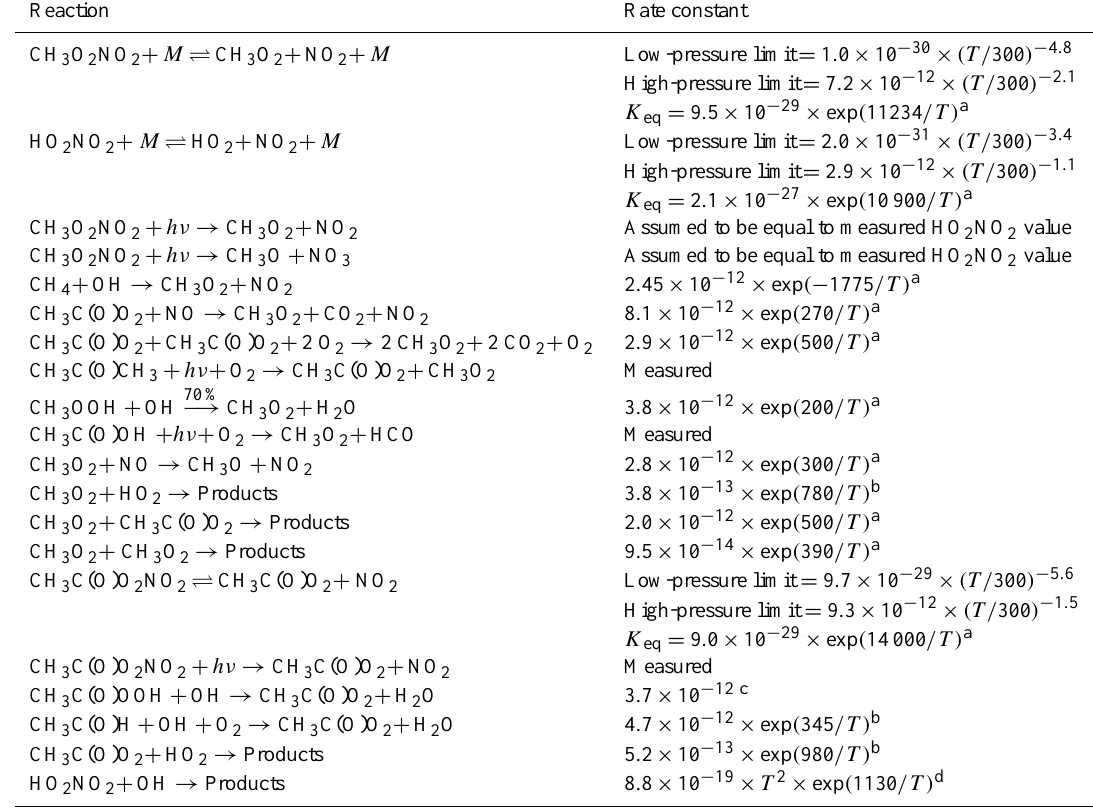
Table 2. Reactions and rates used in calculating dissociations in instrument and photostationary steady-state calculations for CH 3 O 2 NO 2 . Reaction Rate constant CH 3 O 2 NO 2 + M (cid:10) CH 3 O 2 + NO 2 +